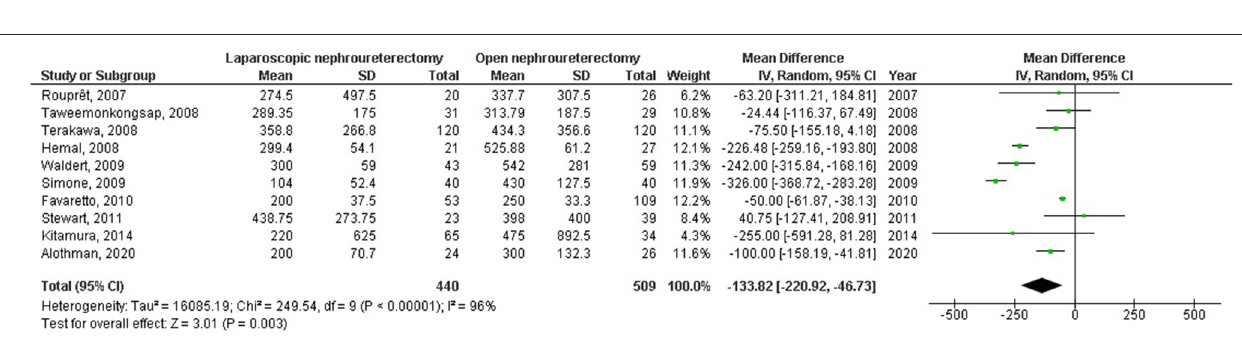
FIGURE 6 | Forest plot of the effect of open nephroureterectomy compared with laparoscopic nephroureterectomy on overall complication in subjects with upper urinary tract urothelial